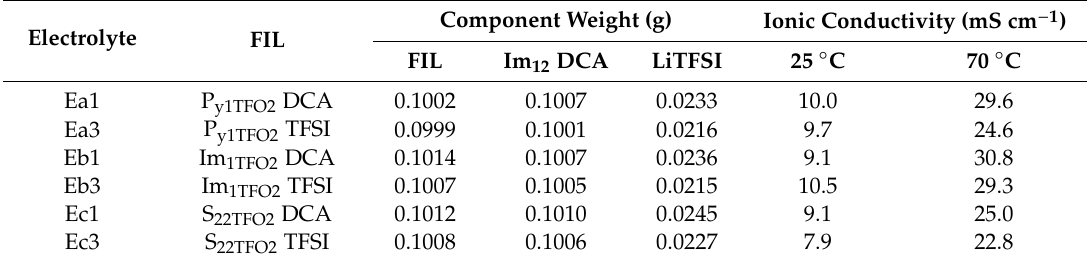
Table 4. Properties of FIL-based formulated electrolytes containing 0.5 M LiTFSI [33].